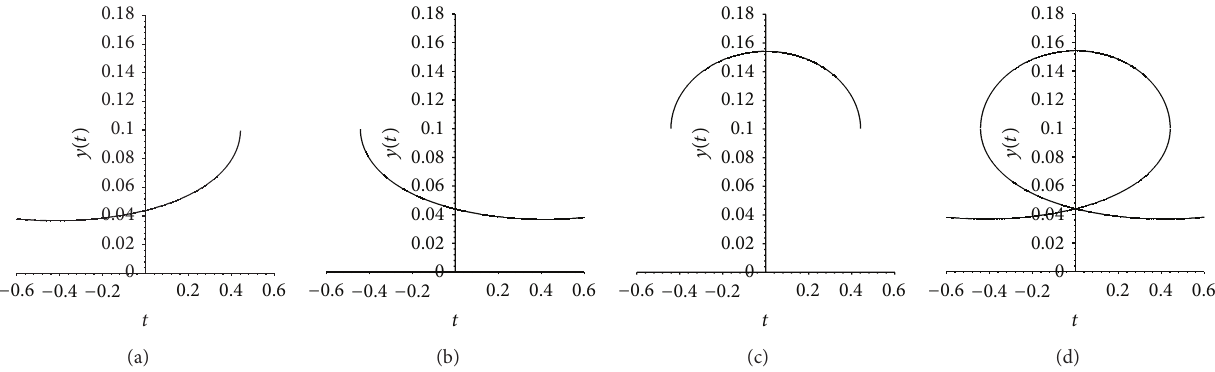
Figure 6: The profiles of waves when 𝛼 < 0 , (𝑟,𝛽) ∈ 𝐴 4 . (a) shows the kink wave corresponding to the unstable manifold. (b) shows the kink wave corresponding to the stable manifold. (c) shows the breaking wave corresponding to the open curve passing through the point 𝑂(0, 0) . (d) shows the wave profile of three curves—loop